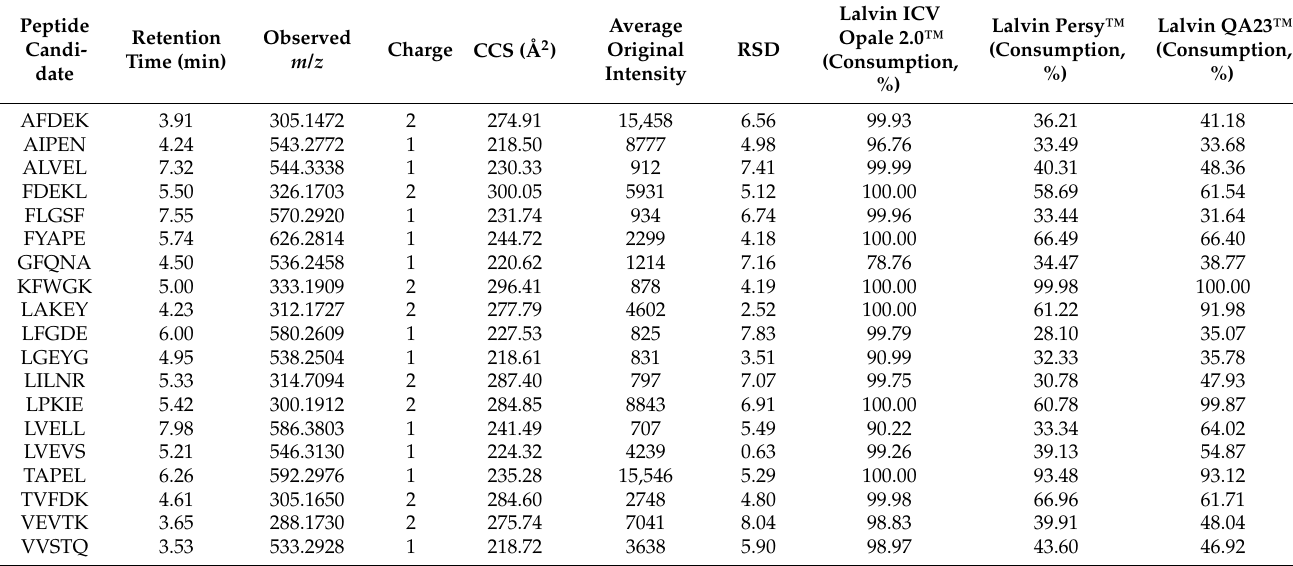
Table A7. The proposed pentapeptide sequences and observed relative consumption during fermen- tation with Lalvin ICV Opale 2.0™, Lalvin Persy™ and Lalvin QA23™ of the modified synthetic must. Peptide sequences were acquired by peptide mapping to bovine serum albumin protein sequence (UniProtKB–P02769 (ALBU_BOVIN)). Additionally presented are the retention time, observed m/z , collision cross section values, as well as the averaged peptide intensities at the starting point and associated relative standard deviations.